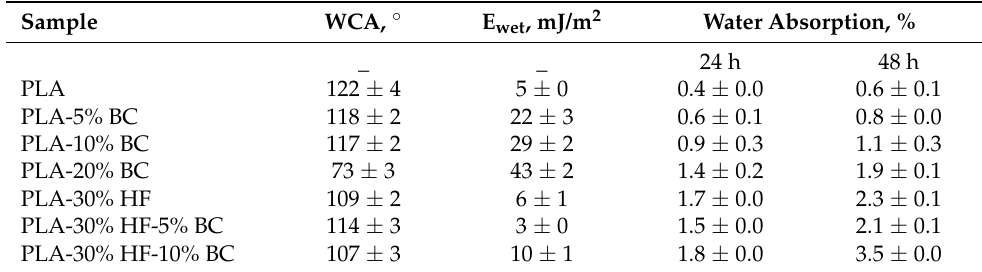
Table 7. Water contact angle, wetting energy, and water absorption results of PLA-based composites. Sample WCA, ◦ E wet , mJ/m 2 Water Absorption,